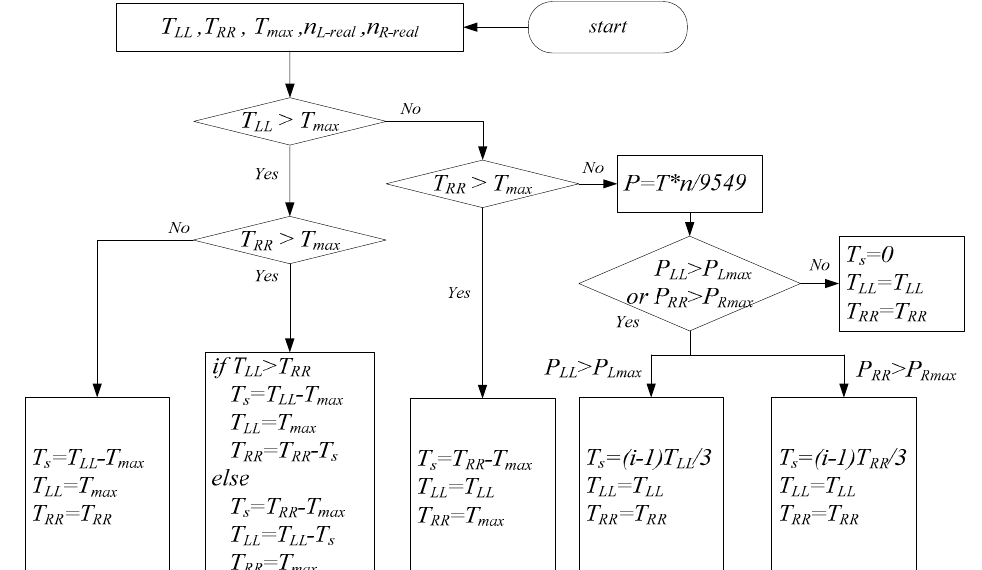
Figure 9. Flowchart of the coupling judgment module.